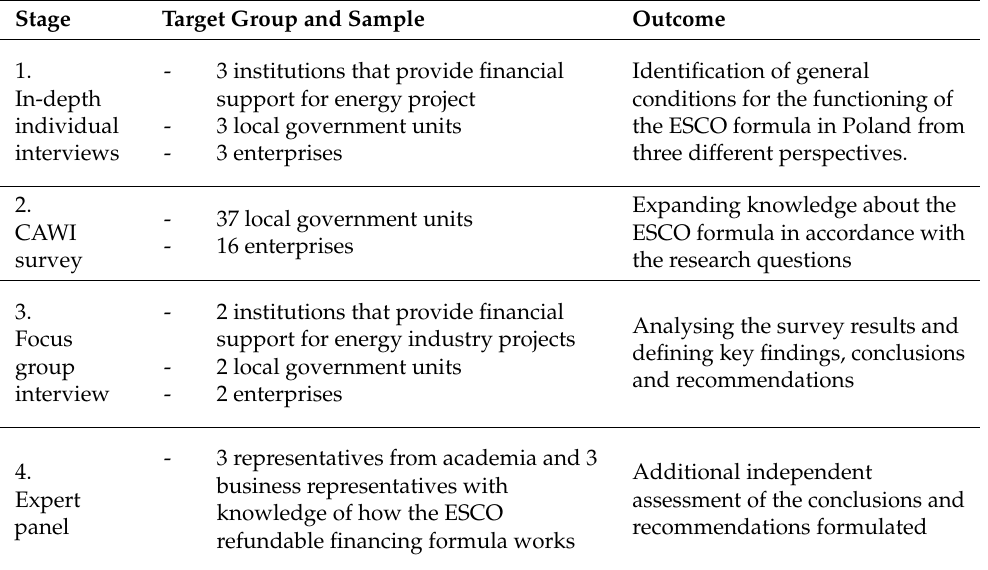
Table 1. The research procedure. Source: own